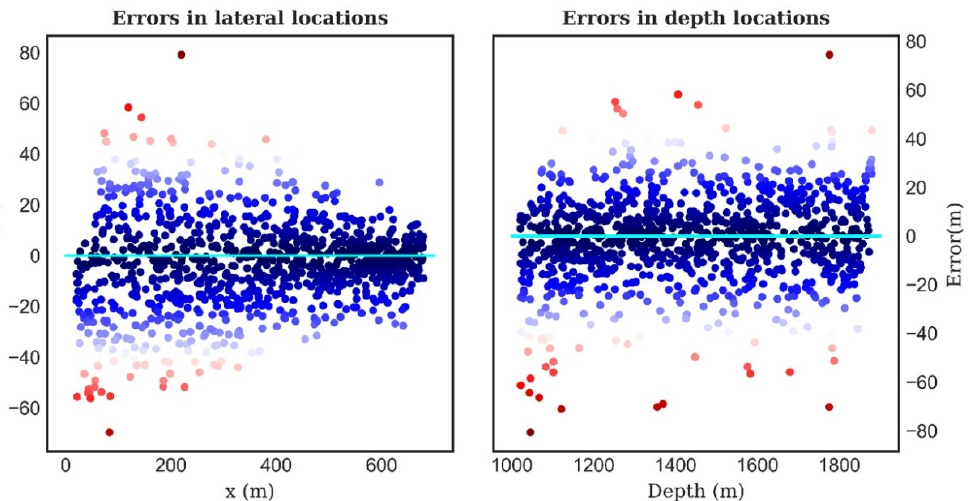
Figure 11. The errors in the locations of the microseismic events. Dark to medium blue are within two standard deviations from the mean, while red is more than two standard deviations from the mean. The events underlying the cyan line had no errors.